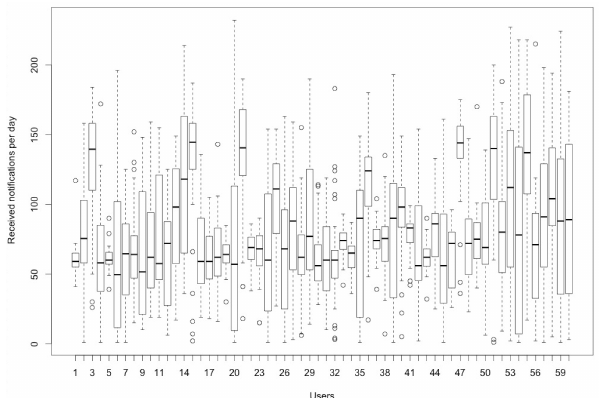
Figure 4: Number of Notifications per User per Day.